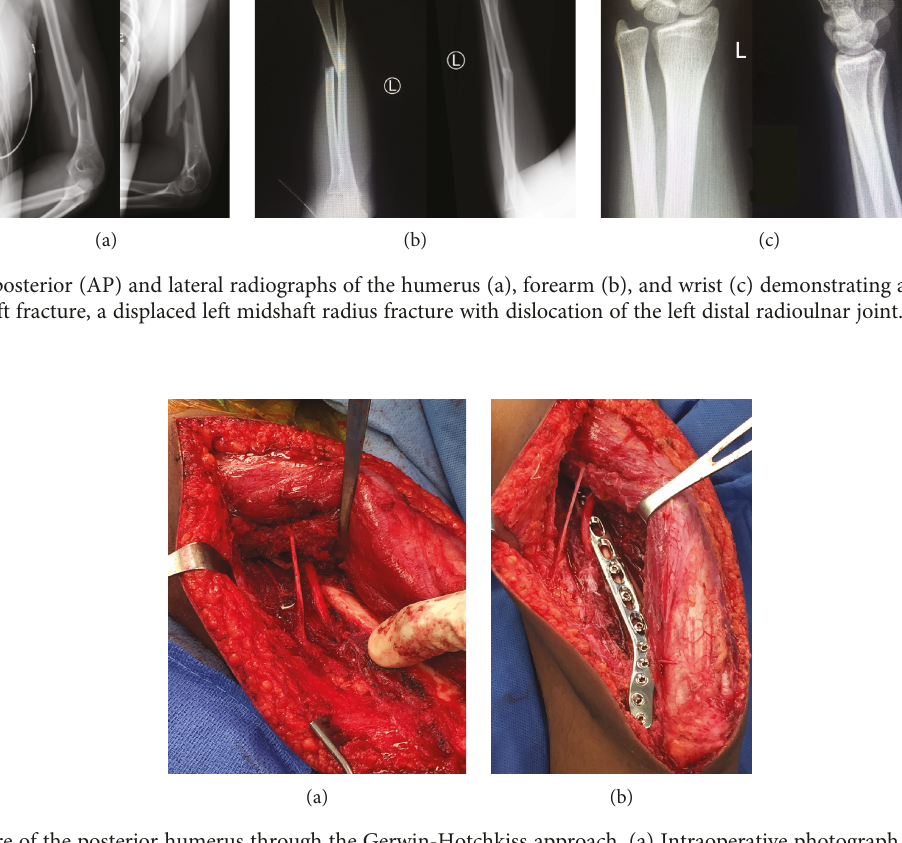
Figure 2: Exposure of the posterior humerus through the Gerwin-Hotchkiss approach. (a) Intraoperative photograph of surgical exposure with retraction of the triceps mechanism medially demonstrating the humeral fracture site and the radial nerve in the spiral groove. (b) Intraoperative photograph after open reduction and internal fi xation of the humeral shaft using an extraarticular locking